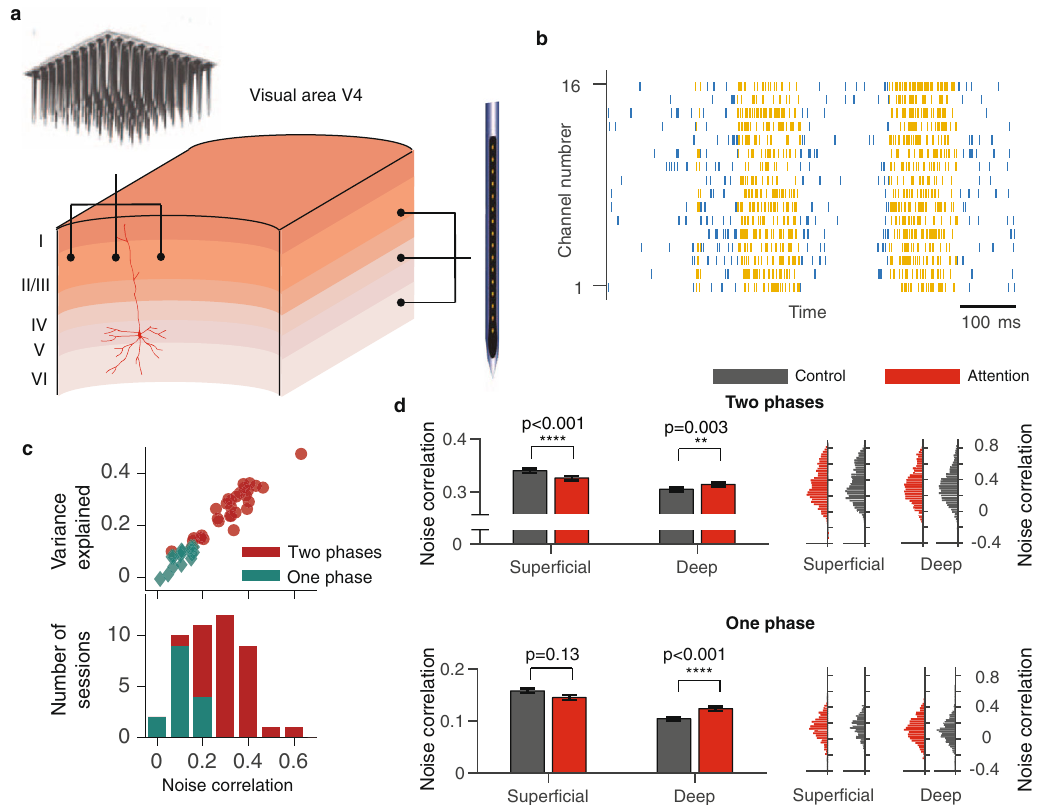
Fig. 1 On-Off dynamics predict the magnitude of noise correlations within cortical columns. a Different recording techniques sample neurons along different anatomical dimensions. A rectangular Utah multi-electrode array (top) samples from laterally separated neurons in different columns, preferentially from super fi cial cortical layers. A linear multi-electrode array (right) samples from neurons across all layers within cortical columns. b An example trial showing spontaneous transitions between episodes of vigorous (On) and faint (Off) spiking in multi-unit activity simultaneously recorded from all layers of a cortical column in V4. Spikes (vertical ticks) on 16 recording channels are segmented into On (yellow) and Off (blue) episodes by the HMM. c Scatter plot of the variance explained by the two-phase HMM versus average noise correlation of MU across recording sessions for two-phase (red circles) and one-phase (teal diamonds) recordings (upper panel). Two-phase HMM accounted for a smaller fraction of total variance in one-phase compared to two-phase recordings, because in one-phase recordings, the fi ring-rate fl uctuations were smaller and most of the total variance was due to unpredictable Poisson variability. Stacked histogram of average noise correlations for two-phase (red) and one-phase (teal) recordings (lower panel). d Average noise correlations of MU in two-phase (upper panels) and one-phase (lower panels) recordings, separately for super fi cial (two-phase: n = 2544 MU pairs for each attention condition; one-phase: n = 920) and deep cortical layers (two-phase: n = 3064 MU pairs for each attention condition; one- phase: n = 1448), in attention (red) and control (gray) conditions (left panels). Histograms show the corresponding distributions of noise correlations in each condition (right panels). Noise correlations slightly decrease in super fi cial and increase in deep layers, but the overall magnitude of changes is very small. p -values are from two-sided t -test (two-phase: p = 2 × 10 − 5 in super fi cial layers, p = 0.003 in deep layers; one-phase: p = 0.13 in super fi cial layers, p = 4 × 10 − 7 in deep layers). Error bars represent SEM. Source data are provided as a Source Data fi